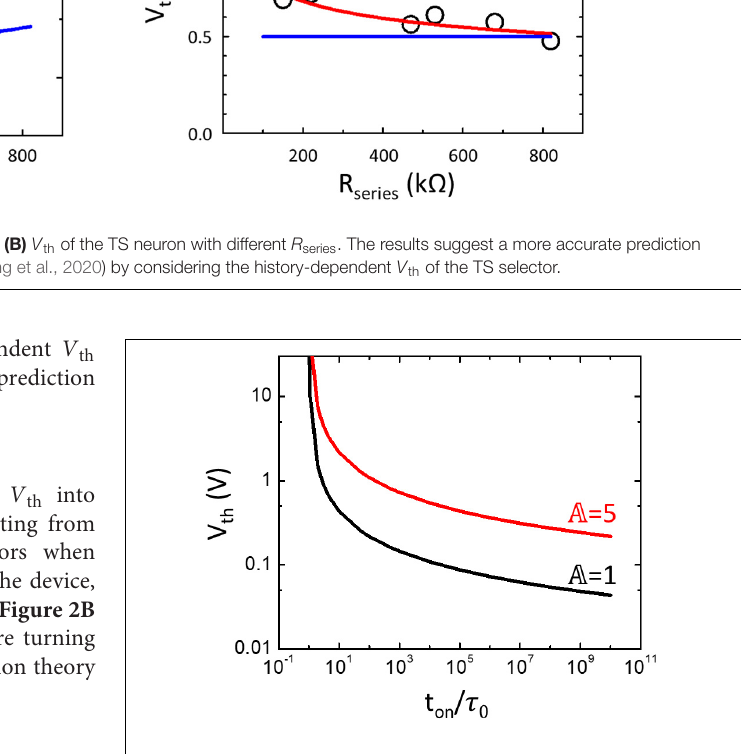
FIGURE 7 | Relation between t on , τ 0 , A , and V th of TS selectors based on the nucleation theory in Equation 2.